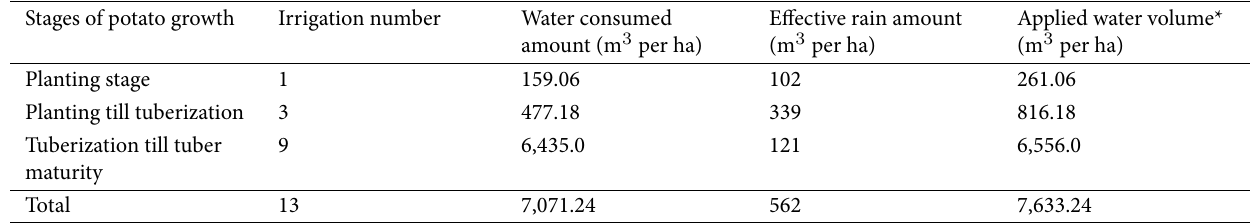
Table 1 Water consumed in different stages of potato growth provided by tape irrigation under normal conditions. Stages of potato growth Planting stage Planting till